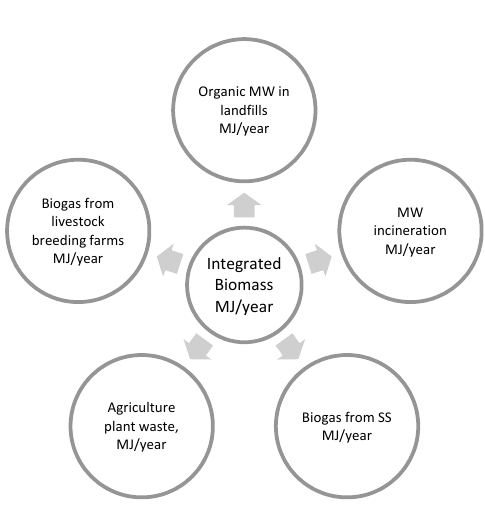
Figure 3. Integrated energy (MJ/year) from available sources of biomass in GS.